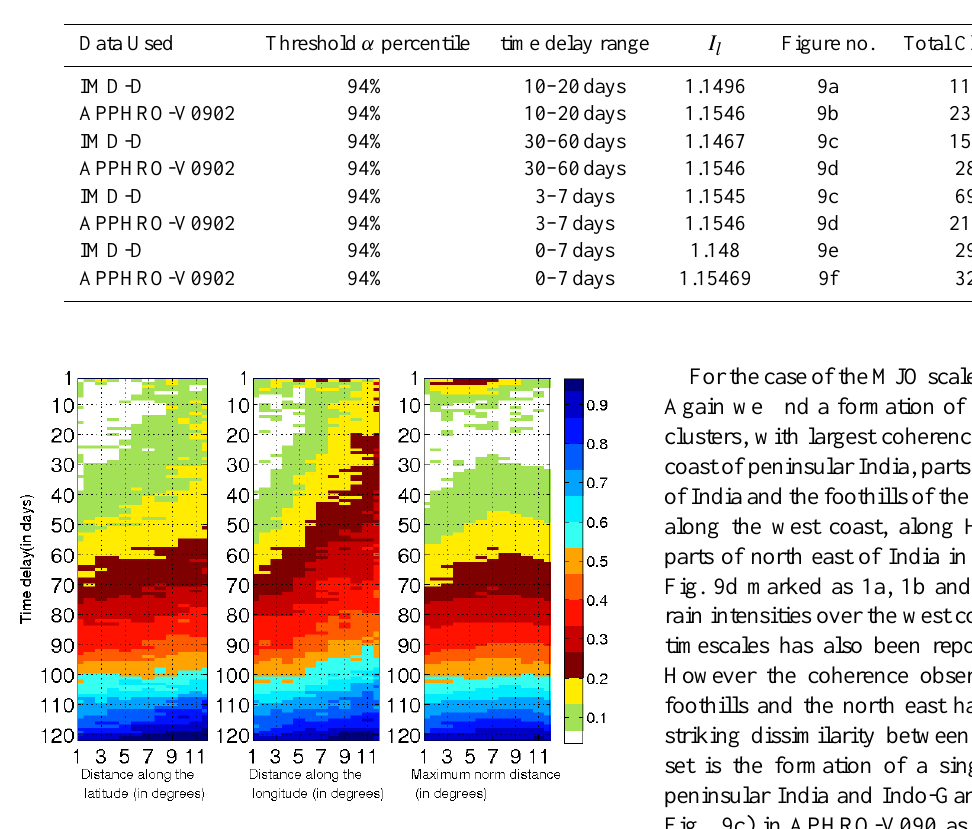
all comparisons between grid with a given distance. The data comparisons between grid with a given distance. The data used to